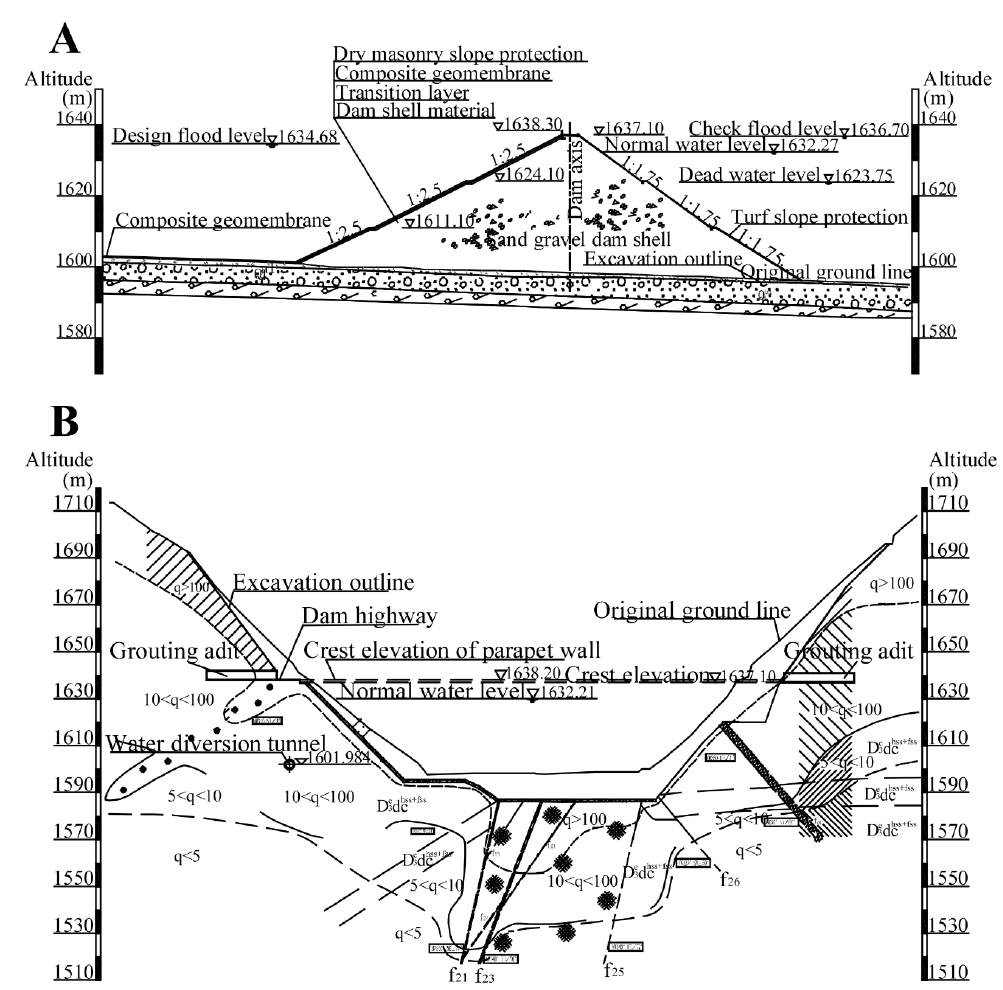
Figure 7. Sections of the Shangmo dam: ( A ) a typical cross section; ( B ) the dam axis section. Table 3. Permeability coe ffi cient of the materials in each